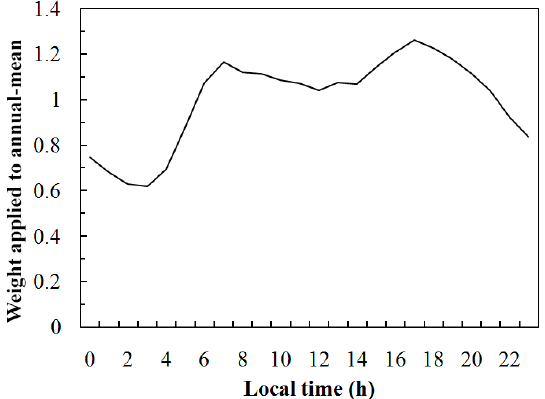
Figure 3. Diurnal variation of anthropogenic heat flux based on He et al. (2007), applied as weights to the annual-mean